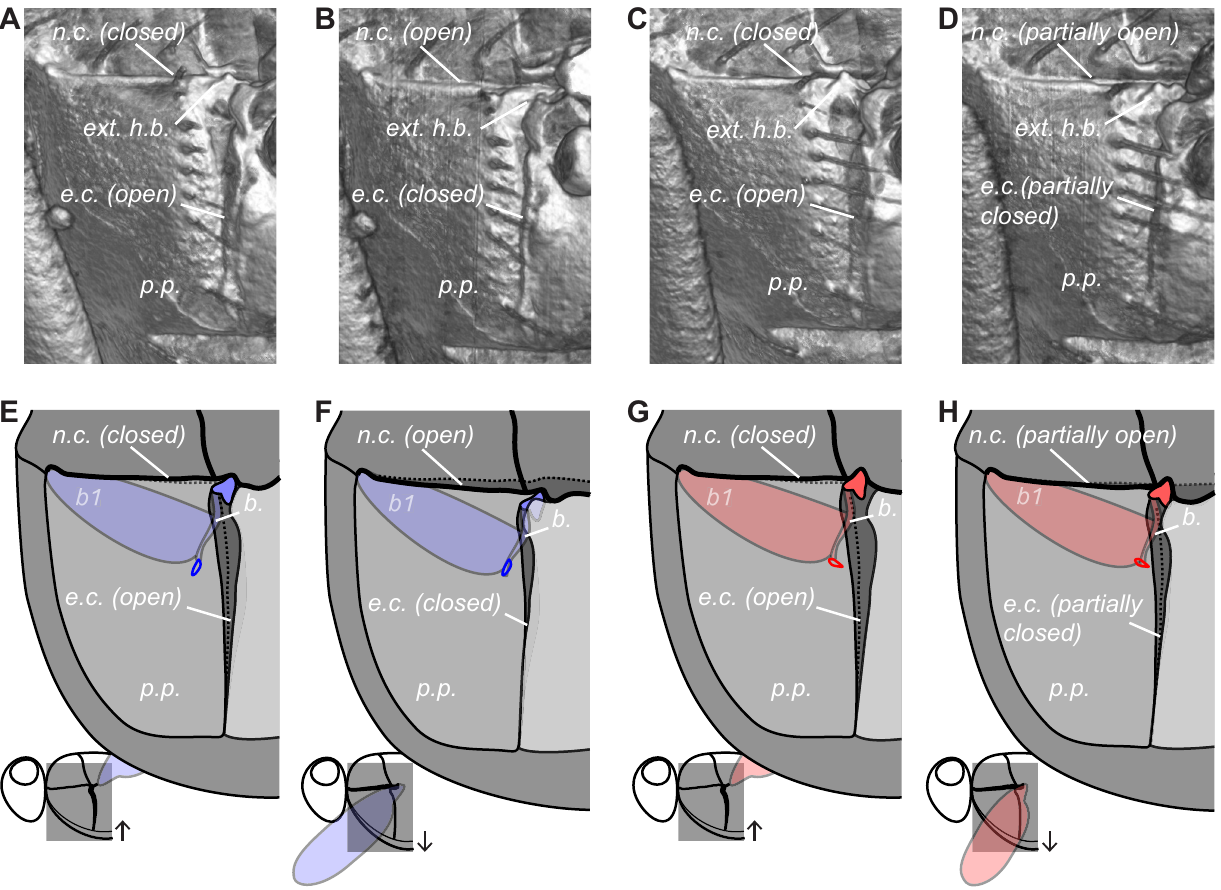
Figure 7. Movements of the basalare sclerite and pleural plate. External visualizations (A–D) and schematics (E–H) of the section of thorax indicated on the inset diagrams for the high-amplitude wing (A,B,E,F) and the low-amplitude wing (C,D,G,H). (A,C,E,G) Start of the downstroke. (B,D,F,H) Start of the upstroke. The pleural plate rotates as the thorax deforms through the wingbeat, causing oscillations of the basalare sclerite, which articulates with it. The small blue (high-amplitude) and red (low-amplitude) loops in (E–H) plot the path of the tip of the internal arm of the basalare sclerite, which oscillates rotationally on the low-amplitude wing and translationally on the high-amplitude wing. Movie S3 animates the external views of these movements through the wingbeat. b ., basalare sclerite; b1 , first muscle of the basalare sclerite; e.c ., episternal cleft; ext. h.b ., external head of the basalare sclerite; n.c ., notopleural cleft; p.p ., pleural plate. Movie S3 can be viewed here.